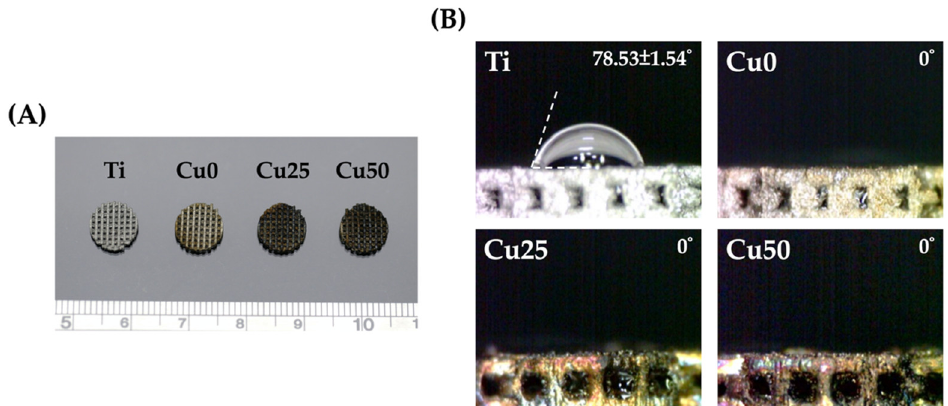
Figure 2. ( A ) The appearance of printed structure before and after PDA/Cu coating, with the in- crease of Cu concentration, the appearance of the scaffold becomes darker. ( B ) Contact angle of water droplets on the scaffold. Except for the untreated group, the other three groups exhibited a super hydrophilic state. Data presented as mean ± SEM, n = 6 for each group.